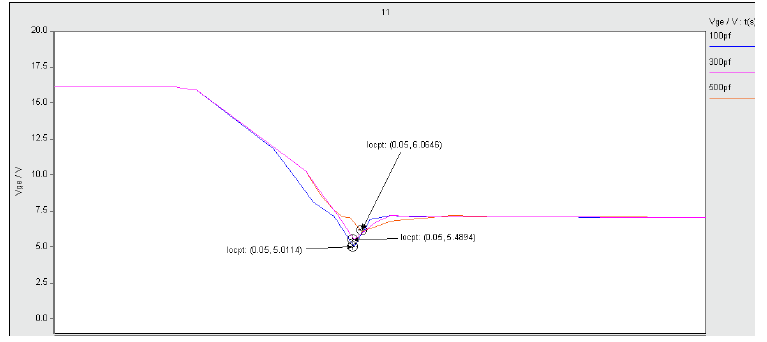
Figure 5. V ge comparison diagram under different C 1